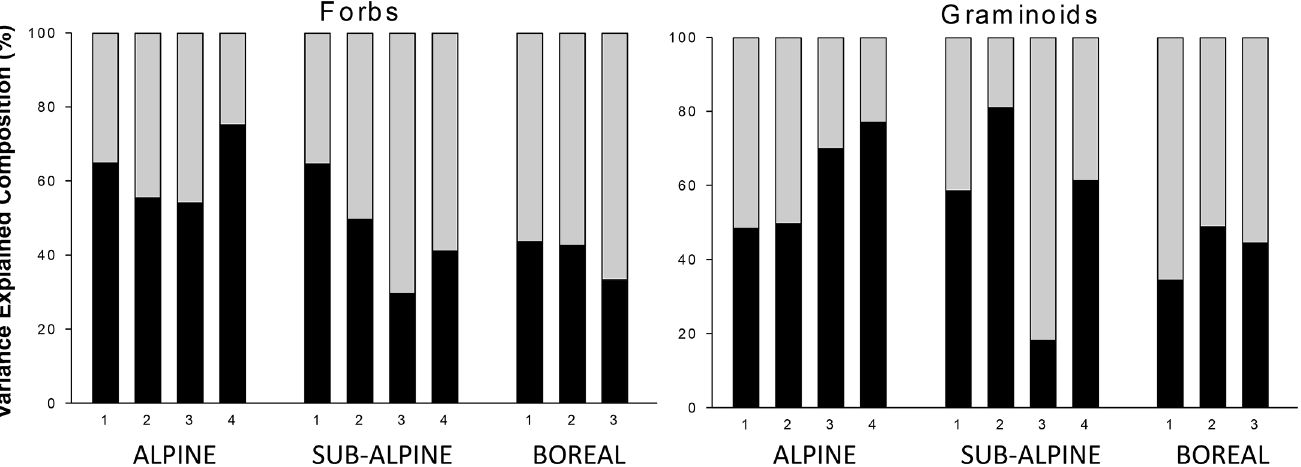
Fig 4. Variation explained by abiotic vs. biotic variables. Relative variation in species composition explained by abiotic (black) and biotic (grey) environmental variables in site-wise redundancy analyses (RDA) performed across eleven grassland sites in alpine, sub alpine and boreal sites along a precipitation gradient from low (1) to high (4) in southern Norway. LOI refers to Loss-On-Ignition, a measure of soil organic